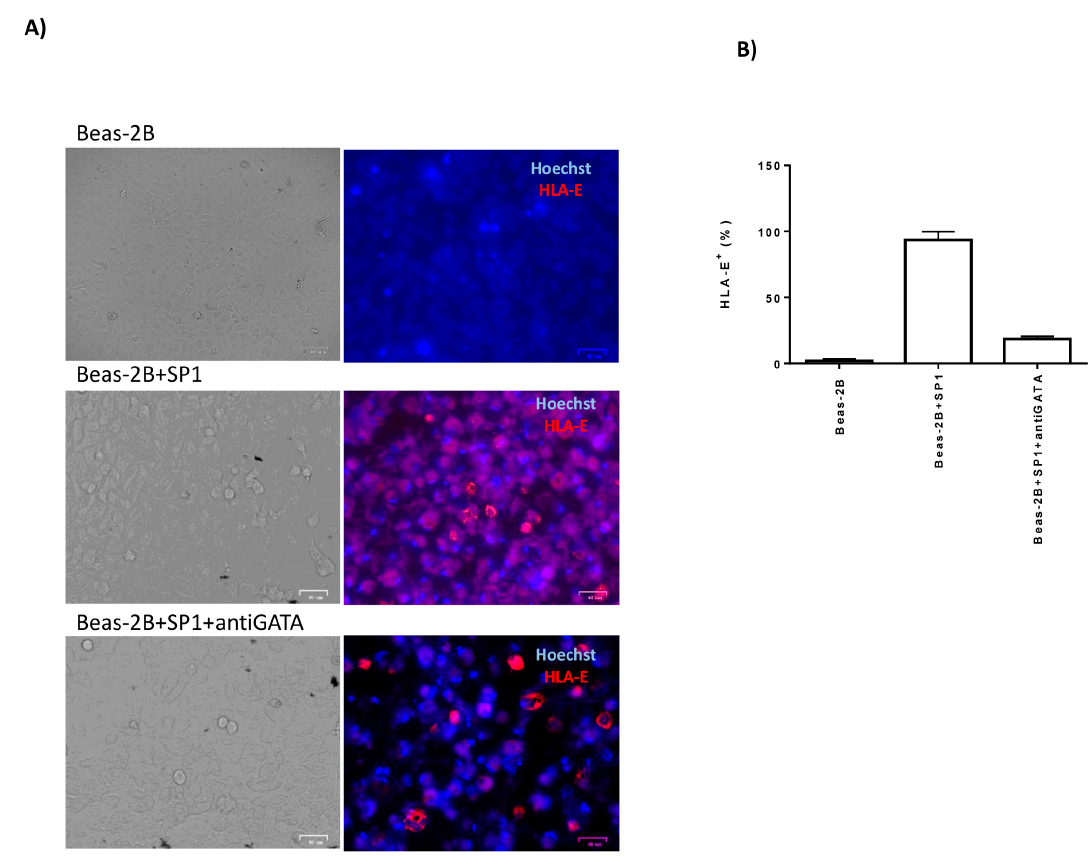
Figure 5. HLA-E expression in Beas-2B cells was characterized by immunofluorescence (Nikon Eclipse TE2000S, equipped with a digital camera). The evaluation was assessed after SP1 transfection (SP1) withoutorwithGATAinhibitor(antiGATAinhibitor). ( A )ThecellswerestainedwithHoechstfornuclear detection and anti-HLA-E-PE monoclonal antibody (clone MEM-E / 08, Exbio, Praha, Czech Republic). Original magnification 40 × . ( B ) Percentage of HLA-E positive ( + ) cells in the Beas-2B and after SP1 transfection (SP1) without or with GATA inhibitor